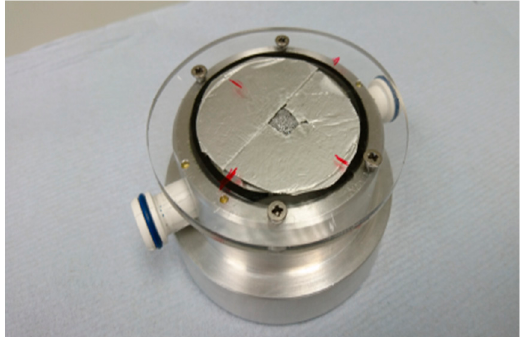
Figure 21. The flow cell fabricated [42].